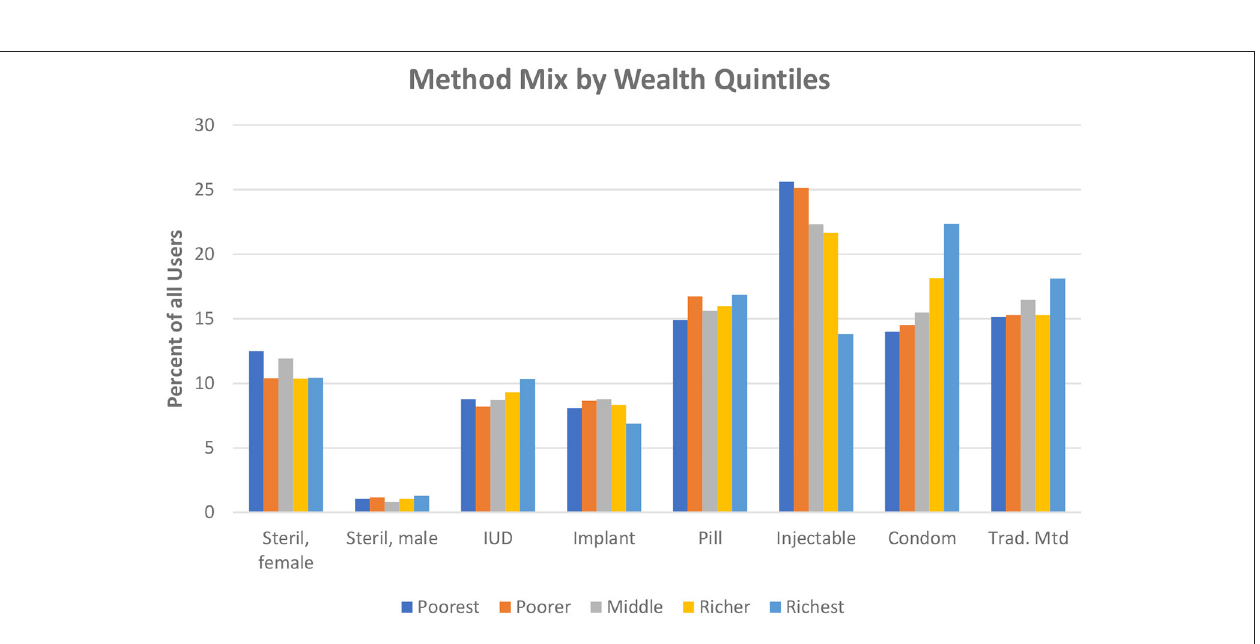
FIGURE 5 | Method mix by wealth